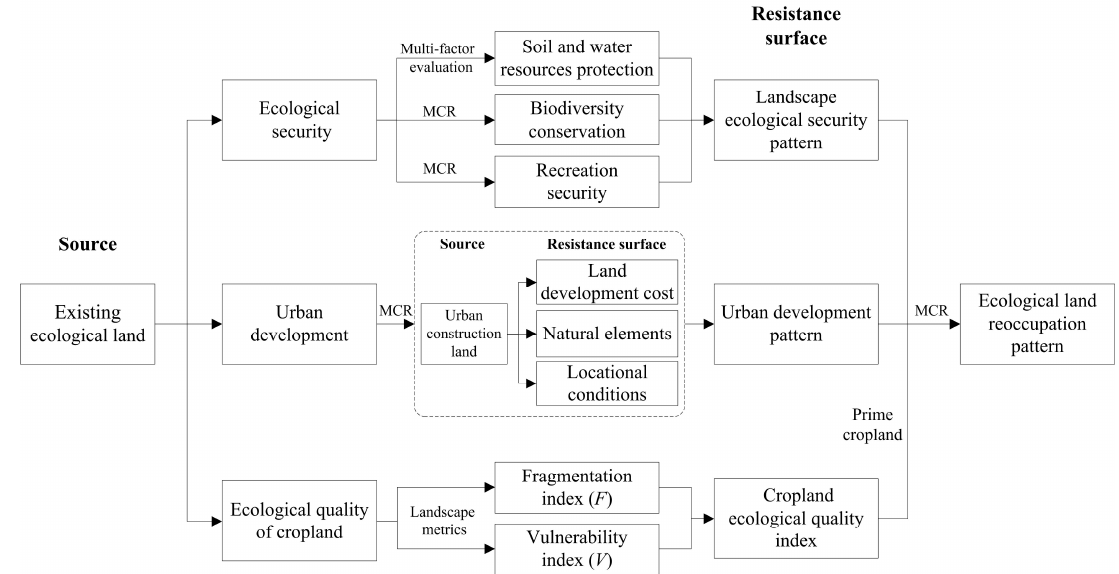
Figure 3. Analysis procedure and methods.